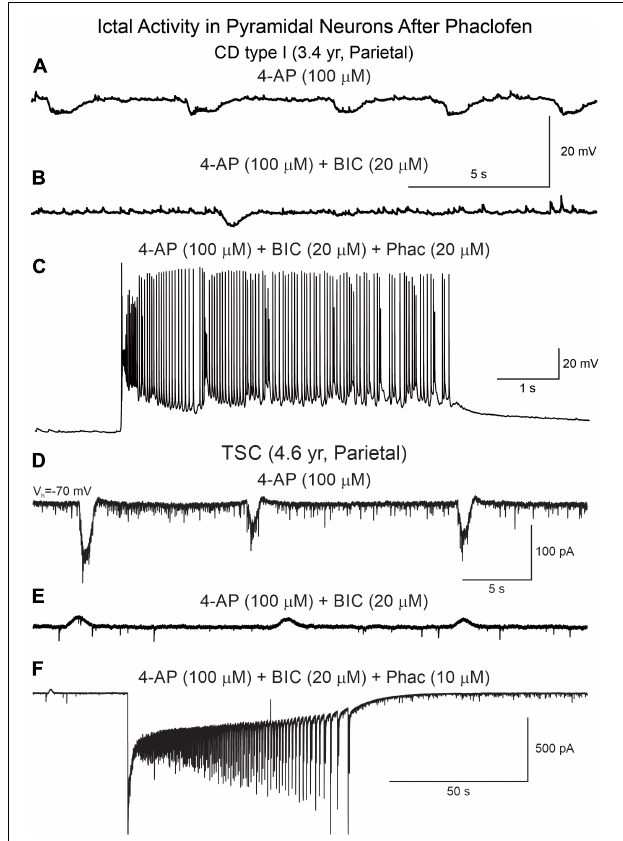
FIGURE 9 | Phaclofen favors the transition to ictal-like discharges in CPNs. (A) Membrane oscillations were induced by 4-AP (top trace). (B) After BIC, the oscillations were reduced. (C) Addition of phaclofen to the mix generated ictal-like discharges. (D) In voltage clamp mode, 4-AP induced rhythmic inward currents. (E) After addition of BIC, the currents became outward and the amplitude was reduced. (F) Phaclofen in combination with 4-AP and BIC induced ictal-like